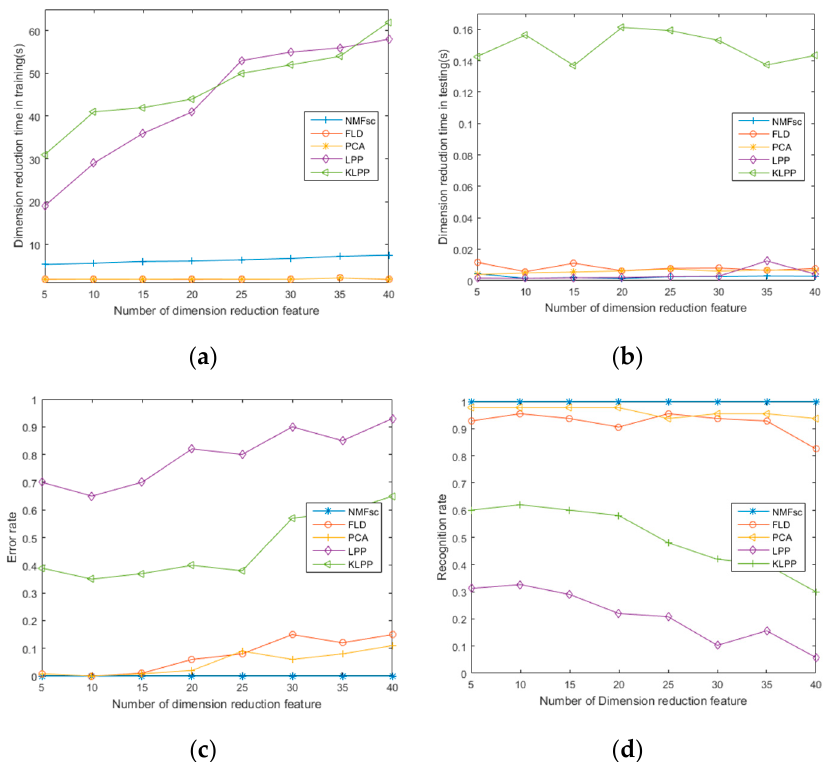
Figure 9. Experimental comparison of different reduction method: ( a ) dimension reduction time in training; ( b ) dimension reduction time in testing; ( c ) error rate; ( d ) recognition rate.